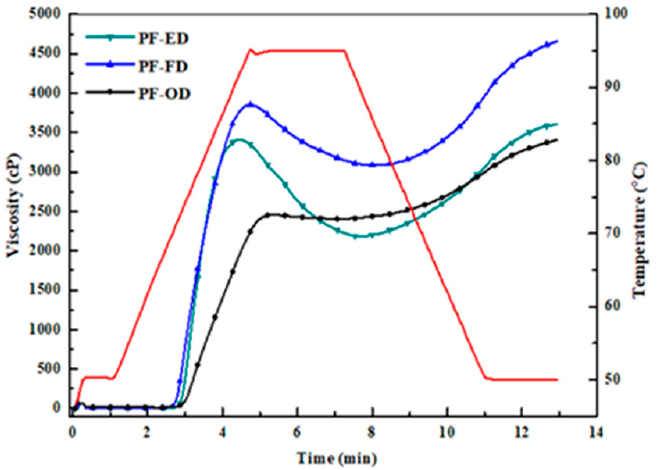
Figure 3. RVA profiles of potato flour samples subjected to different drying methods. PF-ED: potato flour dried for ethanol drying; PF-FD: potato flour dried for freeze drying; PF-OD: potato flour dried for oven